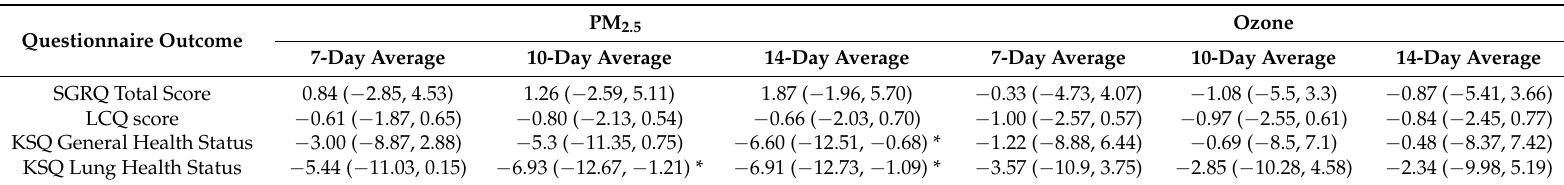
Table 4. Association between air pollution exposure and questionnaire